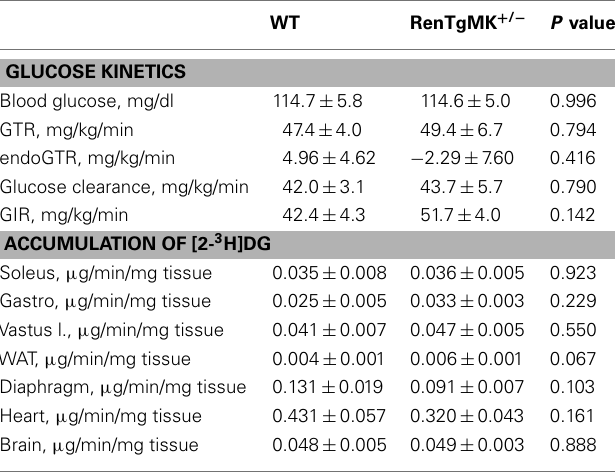
Table 2 | Metabolic characteristics and accumulation of [2- 3 H]DG during the hyperinsulinemic-euglycemic clamp experiments in male wild-type and RenTgMK + / −